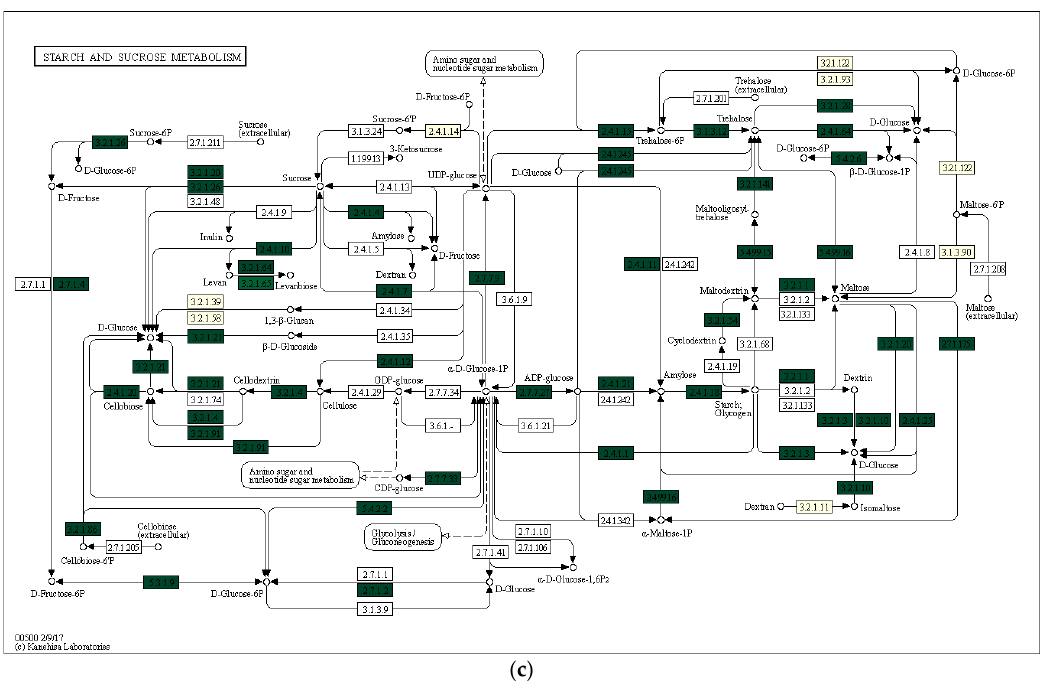
Figure 7. Key degradation enzymes of starch and sucrose metabolism in samples of alluvial brown soil ( a ), leaf litter ( b ) and soil from epiphyte baskets ( c ) collected in the Pu Hoat Nature Reserve. The saturation of the green color is determined by the representation of a particular enzyme in the genomes of microorganisms. EC numbers are taken from the enzyme nomenclature database.